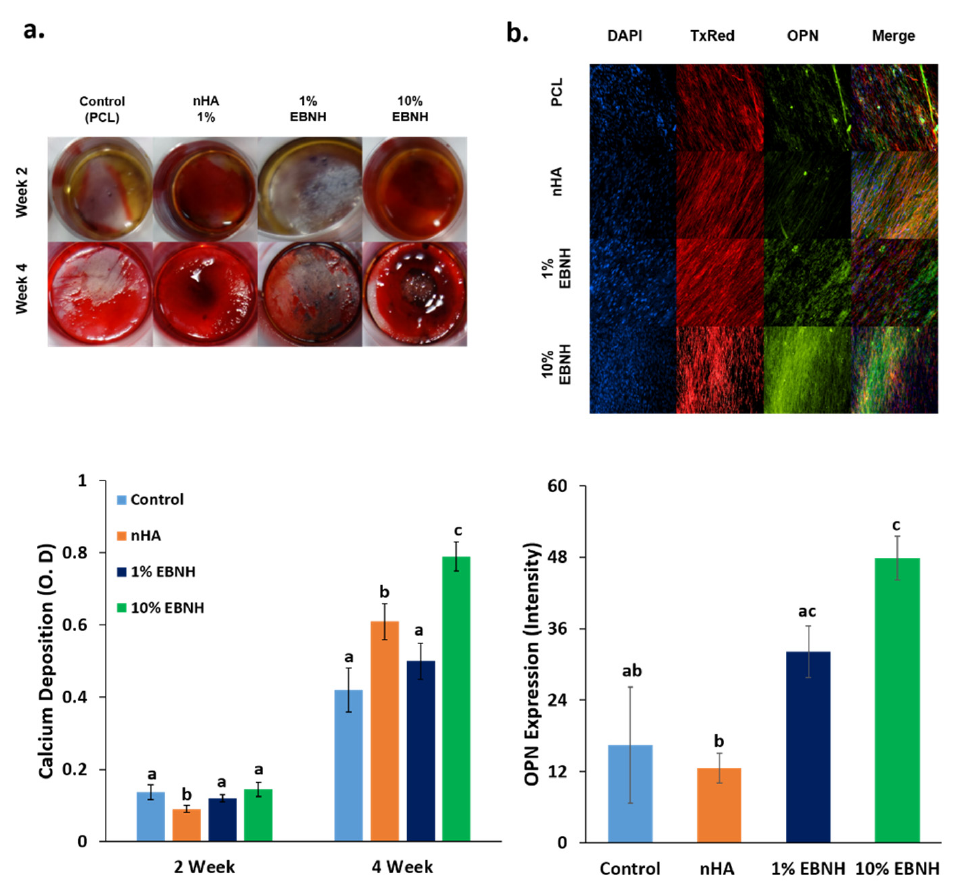
Figure 3. Differentiation of cells on EBNH-RBs. ( a ) Alizarin red staining images and destain results of dental pulp stem cells on nanofiber scaffolds by week. ( b ) Immunocytochemistry (ICC) fluorescent image of dental pulp stem cells 4 weeks after differentiation. DAPI stained the cell nucleus, TxRed (Alexa 594) stained the actin cytoskeleton, and FITC-TRITC conjugated phalloidin stained OPN. (Having non-identical letters, such as a and b, means that the groups have statistically significant differences at p < 0.05 ( n = 5). Groups with common letters to others, such as a and ab, were not significantly different. While the 10% EBNH groups had a significantly high or high tendency in the differentiation assays, it is remarkable that the 1% EBNH group had less calcium deposition but expressed higher levels of OPN than the nHA group.